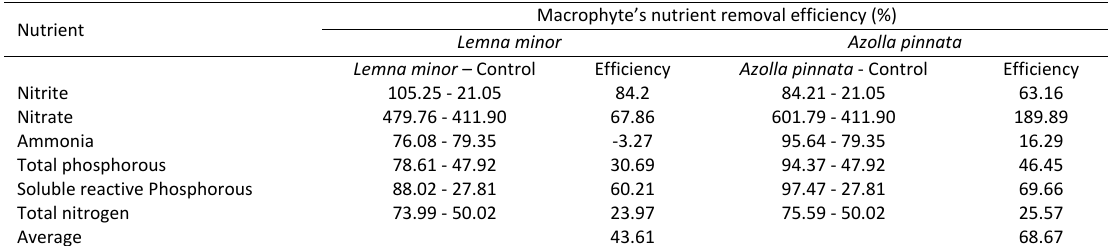
Table 4: Nutrients removal efficiency by the macrophytes